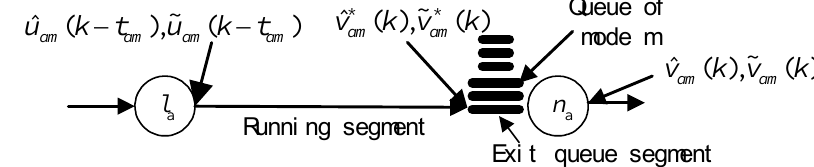
Figure 1. Link flow propagation conditions The link flow propagation conditions are depicted in Fig.1. The equipped and unequipped arrive at the exit queue travelers of mode m entering into link a during time interval k - t am . The arrival segment of link a during time interval k through the constant running time t am flow rates of equipped and unequipped travelers of mode m to the exit queue segment of link )(~ * a during time interval k are )(ˆ * kv and kv , respectively. The departure flow rates of am am equipped and unequipped travelers of mode m from the exit queue segment during time )(~ and , respectively. The link dynamic functions can be expressed as tv interval k are )(ˆ tv am am